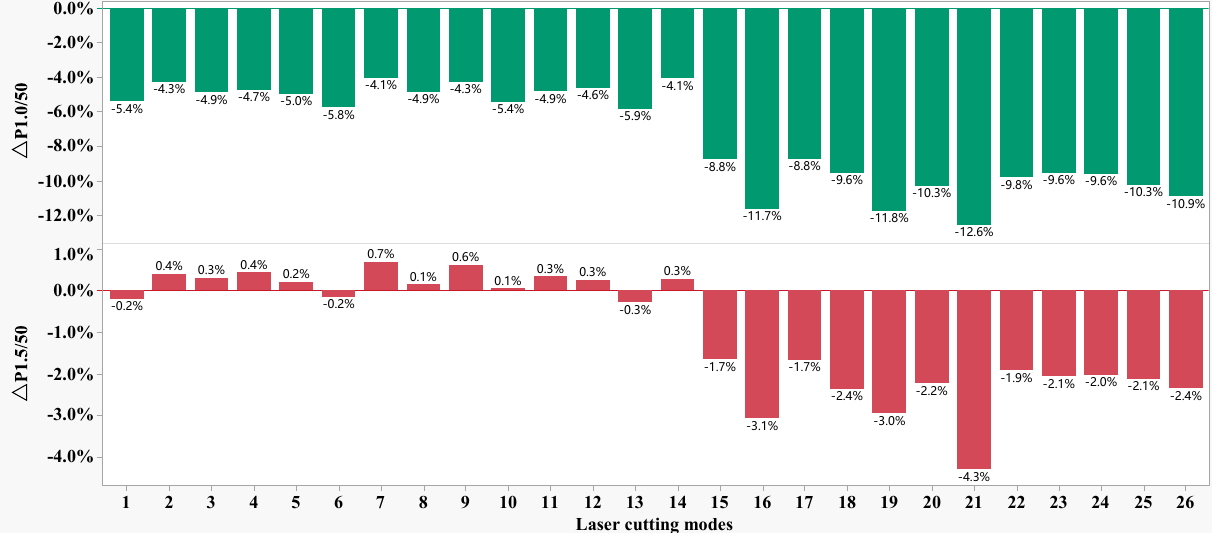
Figure 3. Δ P s distribution under the various laser cutting parameters.